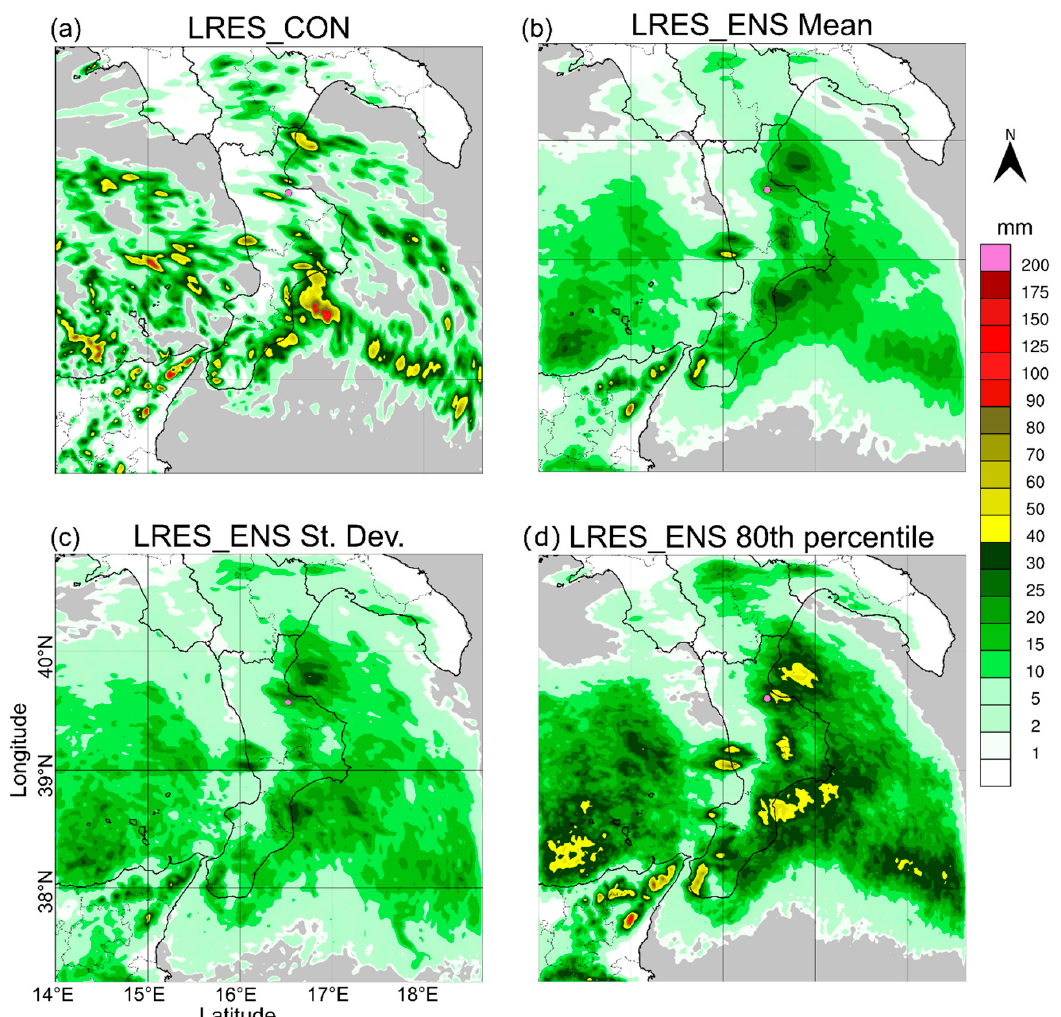
Figure 4. Accumulated precipitation (mm) simulated by WRF using the ECMWF EPS boundary conditions (simulation start at 1200 UTC, 11 August 2015) during the 24-h-long period 1800 UTC, 11 August 2015—1800 UTC, 12 August 2015: ( a ) low-resolution control simulation; ( b ) cell-by-cell mean of the 50 perturbed forecasts, ( c ) same as ( b ), but for standard deviation; ( d ) same as ( b ), but for the 80th percentile. The colored dot represents the Corigliano gauge station.